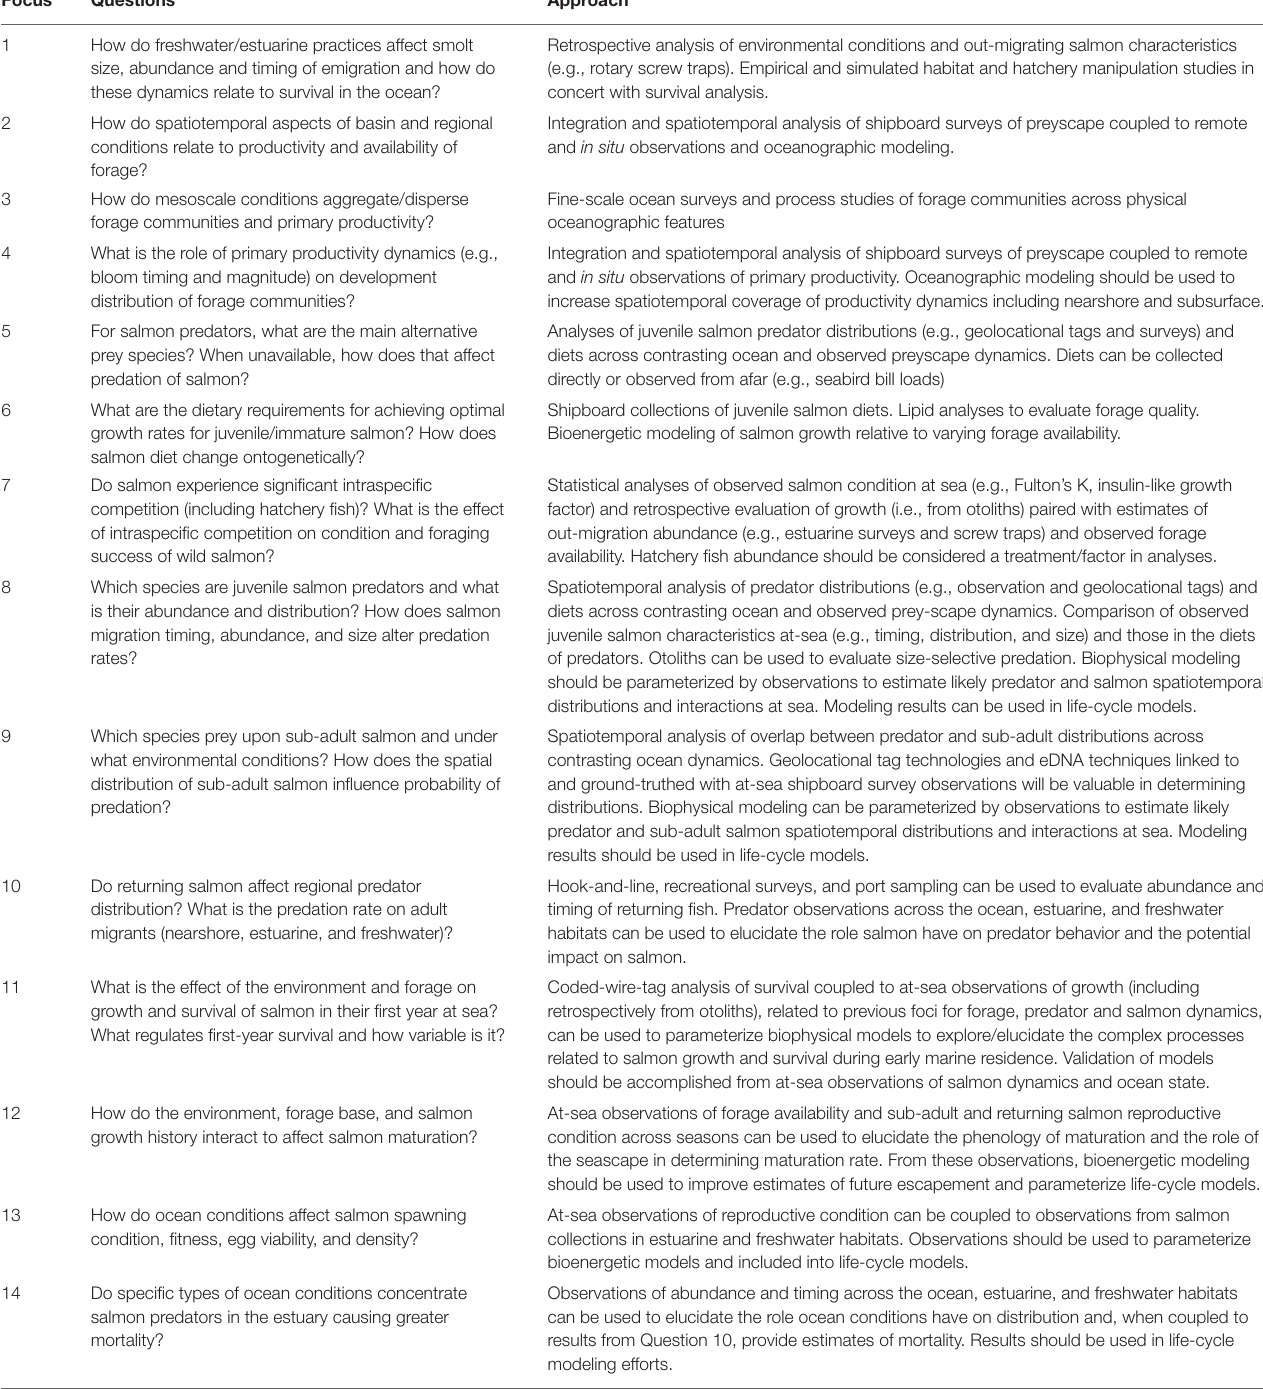
TABLE 1 | Research questions identified by consensus of authors and outside contributors that correspond to research foci indicated in the conceptual model that outlines interactions among ocean ecosystem components, processes and salmon life stages ( Figure 2 ). Focus Questions